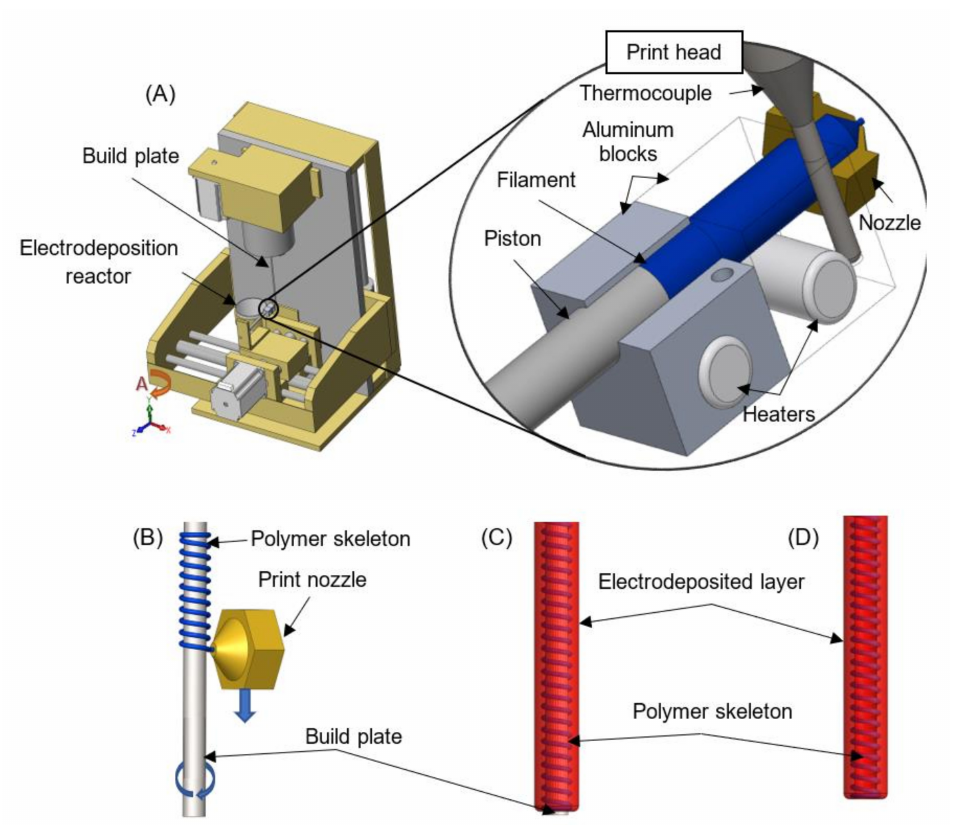
Figure 1. ( A ) Scheme of the apparatus based on polymer extrusion and electrophoretic deposition for fabrication of hybrid implants. Sequence of the manufacturing process: ( B ) polymer extrusion process, ( C ) electrodeposition process, and ( D ) fabricated hybrid implant.